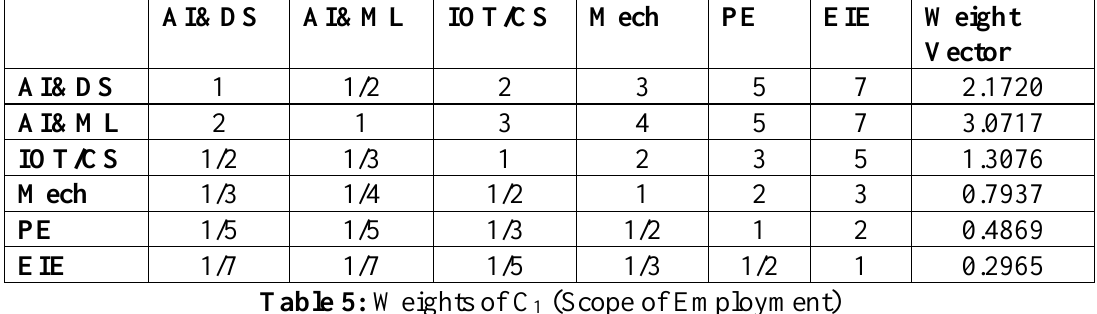
Table 5: Weights of C